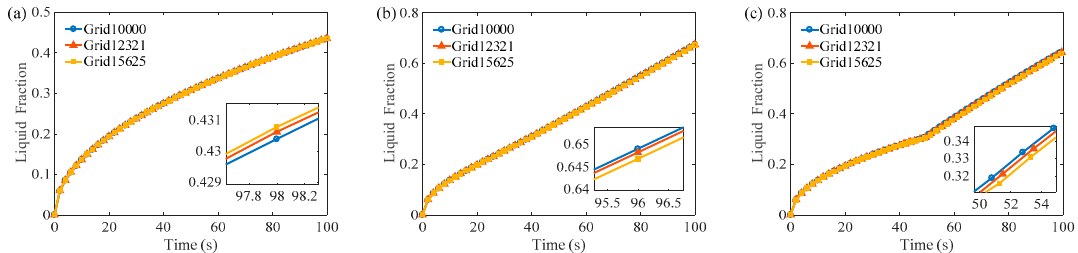
Figure 2. The verification of grid independence at the time step 0.1 s for AR = 1. ( a ) Heating the top side; ( b ) heating the right side; ( c ) heating the bottom side.